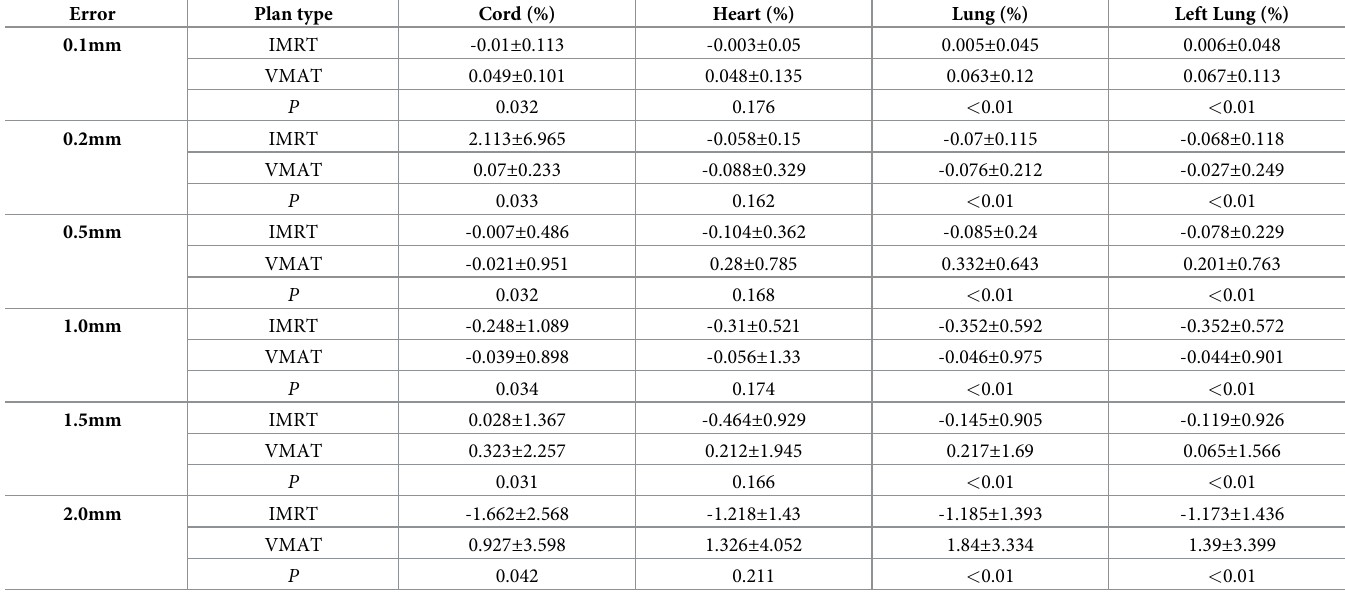
Table 4. The gEUD variation in the OAR of the IMRT and VMAT plan for random error.